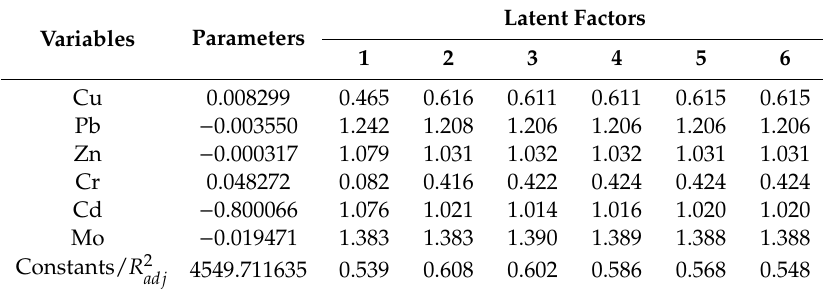
Table 3. Display of multiple PLSR correlation between heavy metal contents and NIR band positions near 4548 cm − 1